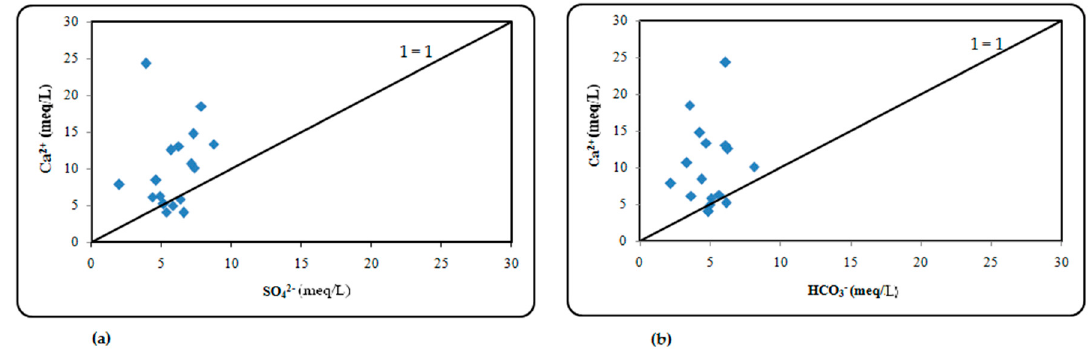
Figure 12. ( a ) Ca 2+ versus SO 42 − and ( b ) Ca 2+ versus HCO 3 − in the groundwater of the catchment.